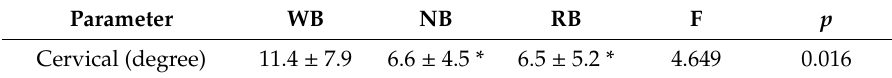
Table 1. Comparison of cervical spine alignment in each condition.